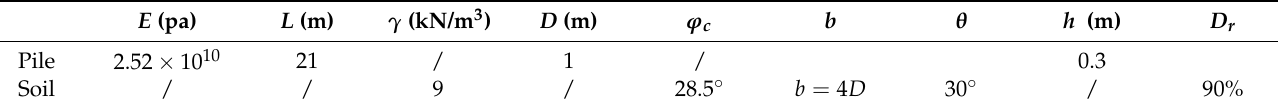
Table 2. Soil and pile parameters in this